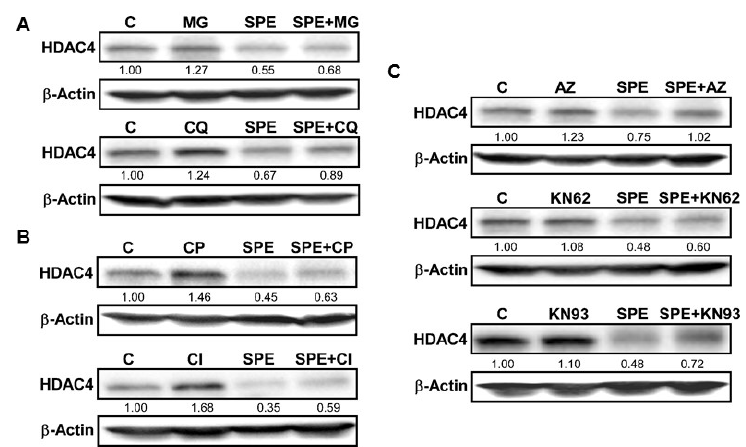
Figure 3. Lysosomal and calpain-mediated degradation of HDAC4 by SPE. ( A ) Western blot analysis of HDAC4 in RAW 264.7 macrophages pretreated with 10 µ g/mL of MG-132 (top), or 50 µ M of chloroquine (bottom) for 1 h and then treated with 25 µ g/mL of SPE in the presence of inhibitors; ( B ) Western blot analysis of HDAC4 in RAW 264.7 macrophages pretreated with calpeptin (10 µ g/mL) for 1 h and then treated with 25 µ g/mL of SPE in the presence of inhibitors; ( C ) Western blot analysis of HDAC4 in RAW 264.7 macrophages pretreated with CAMKII inhibitor KN-93 at the concentration of 5 µ M for 1 h and then treated with 25 µ g/mL of SPE in the presence of inhibitors. A represented blot of three independent experiments is shown.